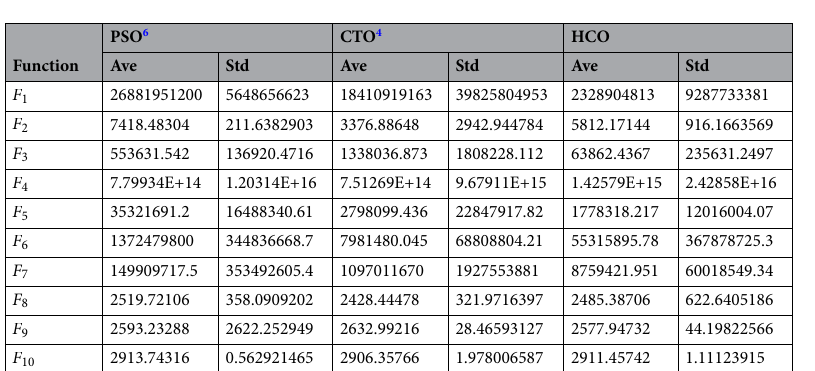
Figure 4. Comparison of convergence performance of HCO for CEC2005.